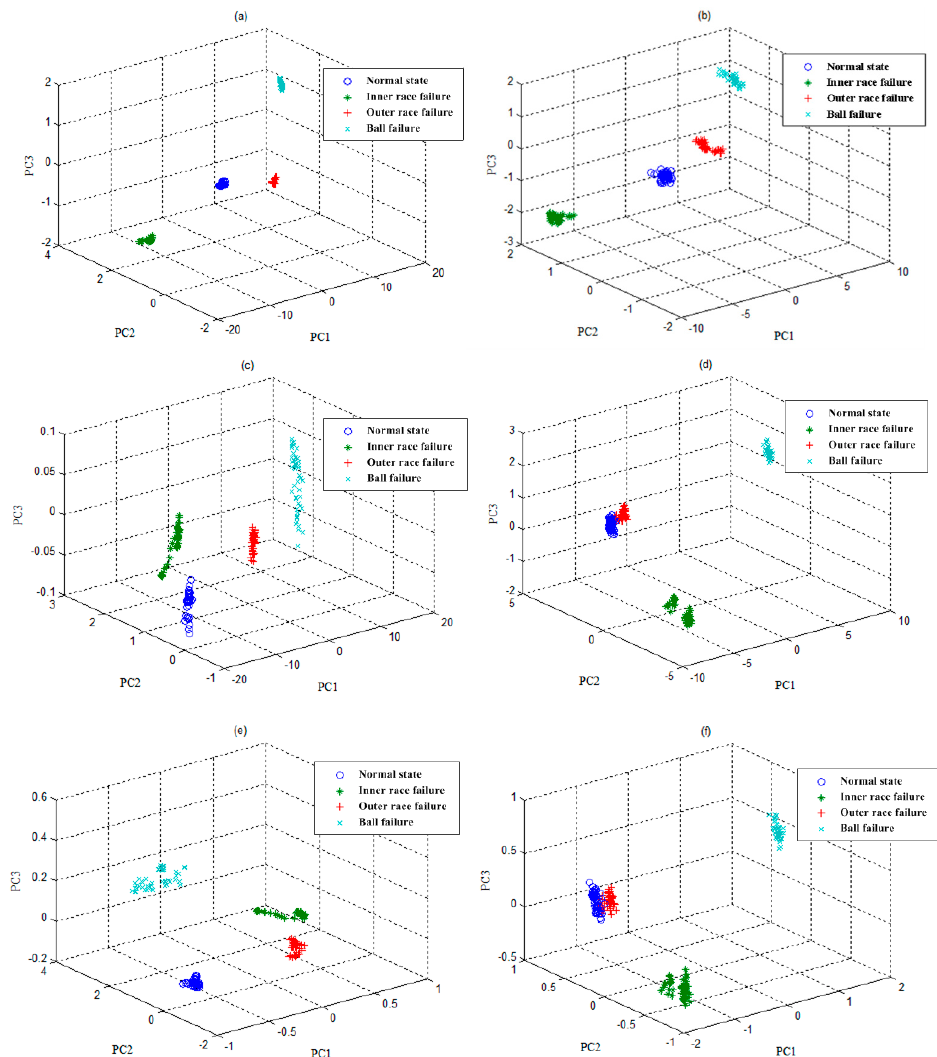
Figure 6. Experiment data for Case II of six kinds of di ff erent KPCA result feature matrix: ( a ) WW 2 H ; ( b ) WP 2 ; ( c ) WD 2 ; ( d ) WI 2 ; ( e ) WL 2 ; ( f ) C 2 .